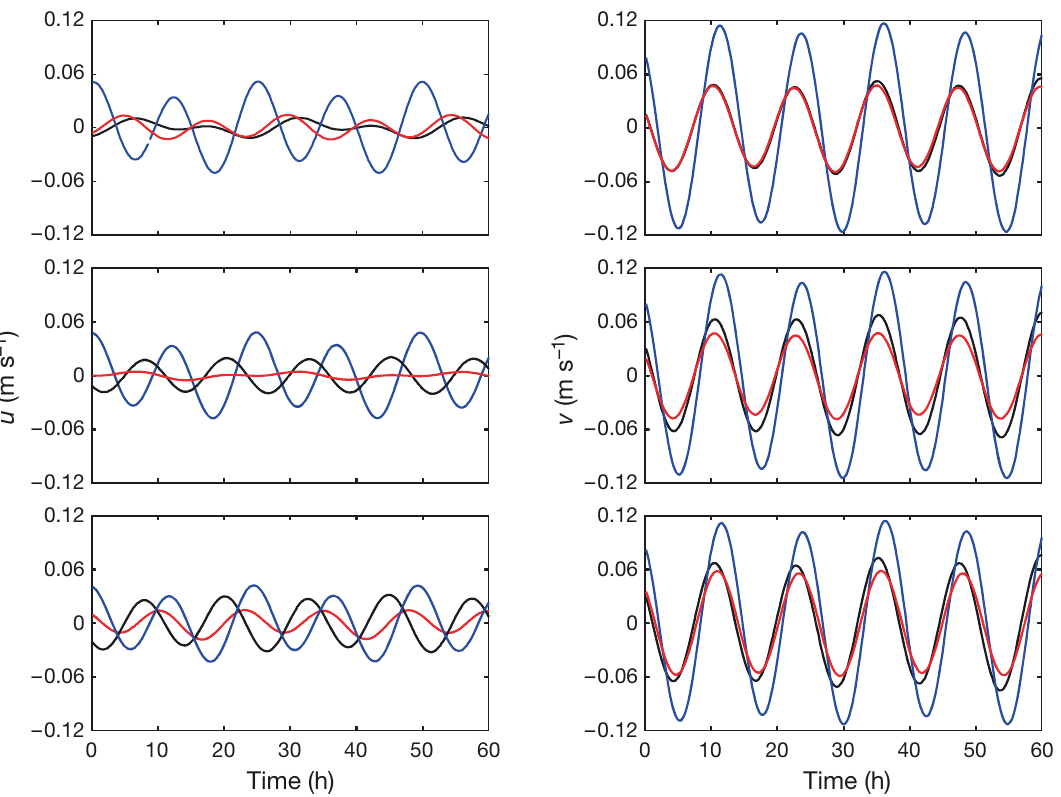
Fig. 4. Time-series comparisons of tidal velocity components u (left) and v (right) between (black) observations, model results obtained without (blue) and with cage effect (red) at Site 6 (for location see Fig. 1C) at selected depth levels of 12 (upper), 8 (middle), and 4 m (lower) above the